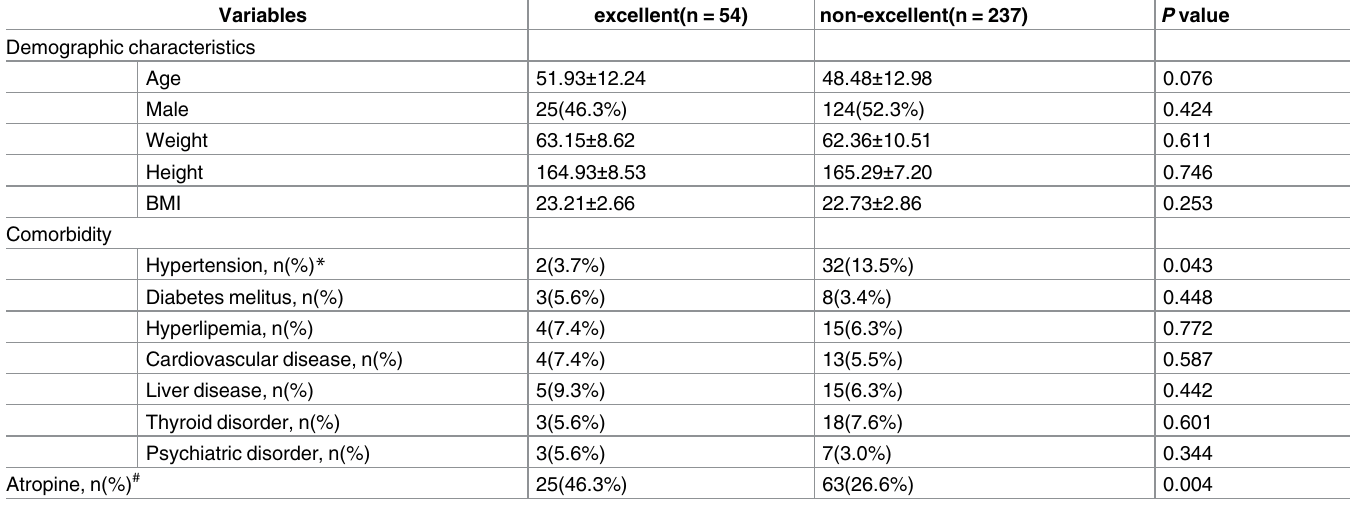
Table 4. Univariate analysis of factors associated with excellent exposure of esophagogastric junction territory during sedation EGD.